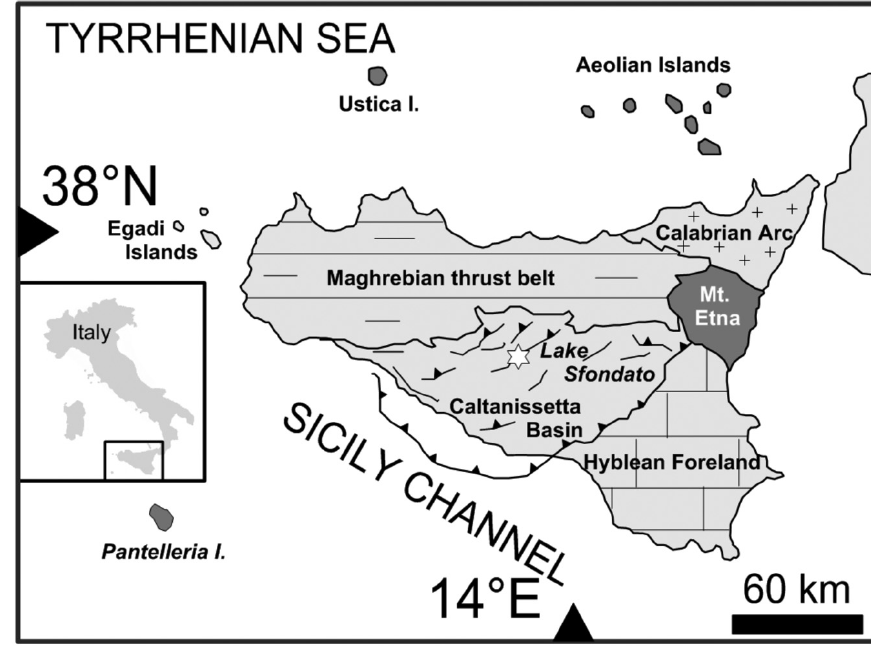
Figure 1. Structural map of Sicily with location of the studied areas; the dark grey polygons represent volcanic